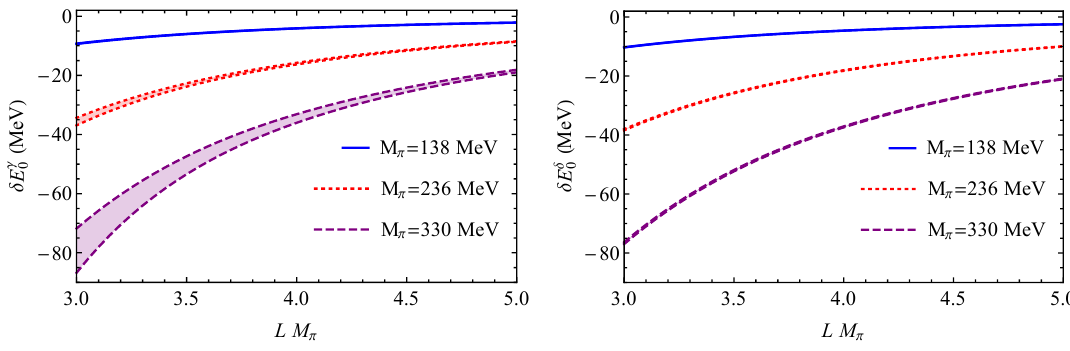
Figure 3 . Prediction of the energy shift (cid:14)E (cid:13) L at M (cid:25) = 138 MeV (blue), 236 MeV (red) and 330 MeV (purple). The de(cid:12)nitions of (cid:14)E (cid:13) can be found in eq. (3.7): (cid:13) corresponds to the channel involving D, C and R types of contractions, and (cid:14) is the isoscalar channel which has all of the D, C, R and V types of